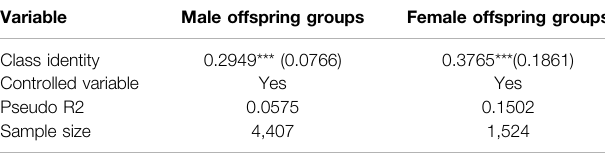
TABLE 3 | Estimated results for different offspring groups. Variable